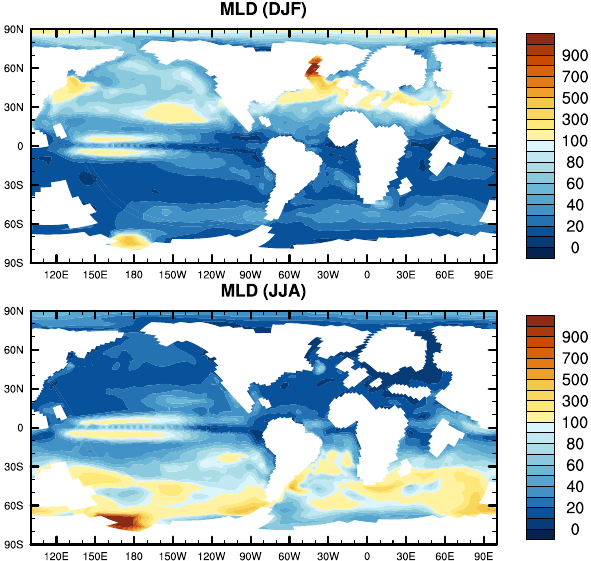
Figure 5. Mixed layer depth (m) averaged over boreal winter (DJF) and boreal summer Fig. 5. Mixed Layer Depth (m) averaged over boreal winter (DJF) and boreal summer (JJA). Figure 4. Globally averaged meridional overturning circulation 24 (Sv) for the late Paleocene (top) and the pre-industrial (bottom). Positive values correspond to clockwise circulation. Pre-industrial values were calculated within CMIP5 experiments.